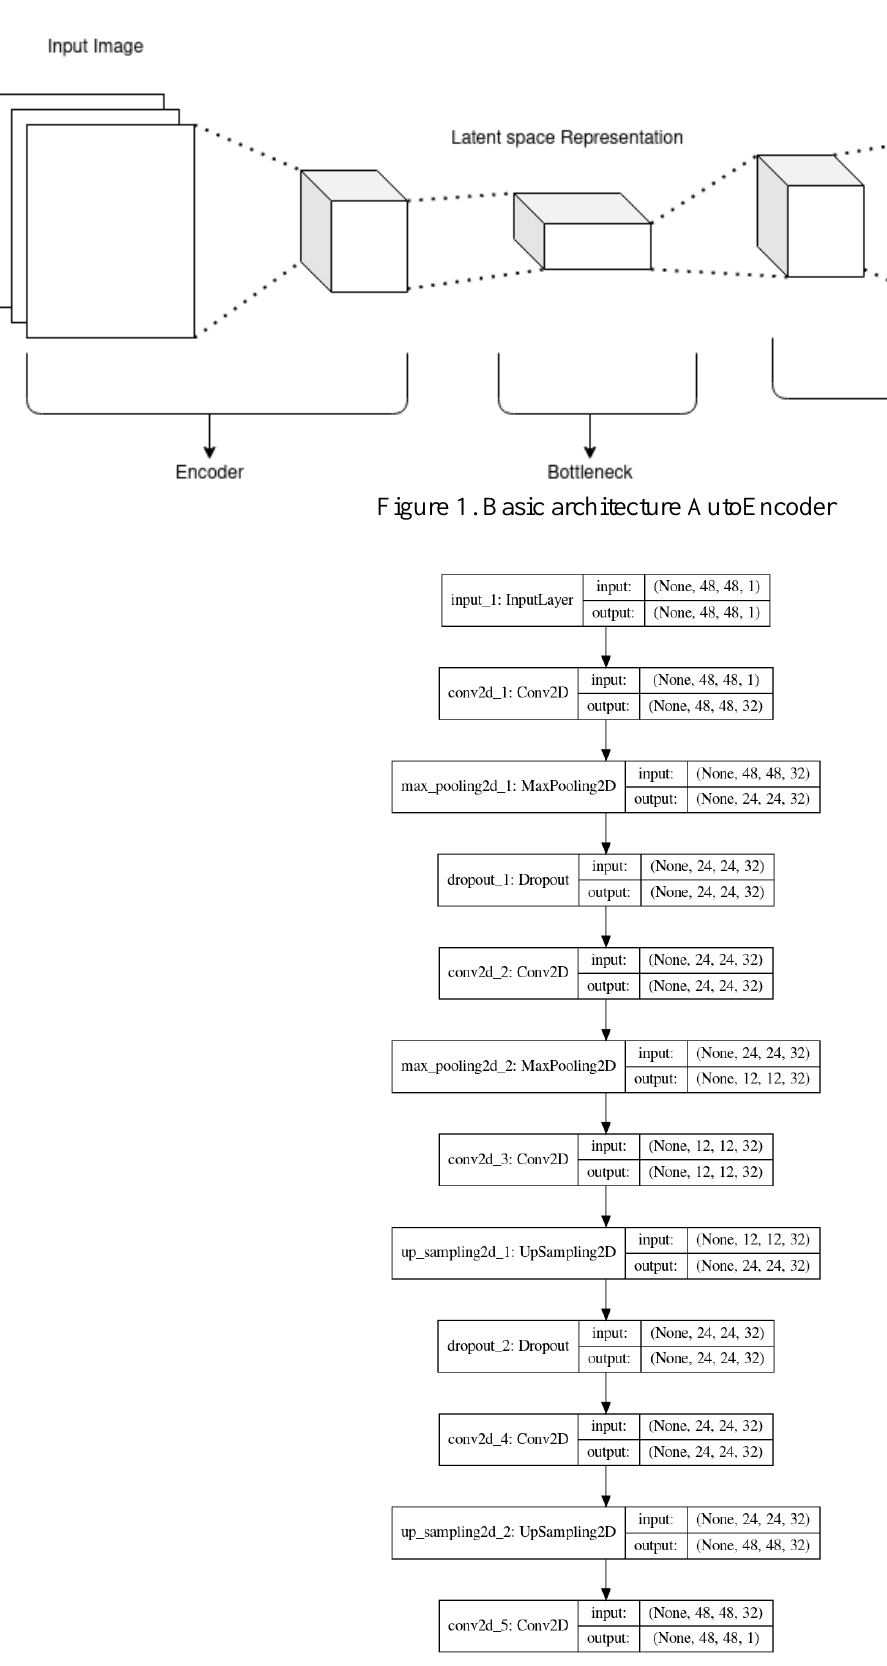
Figure 2. AutoEncoder architecture